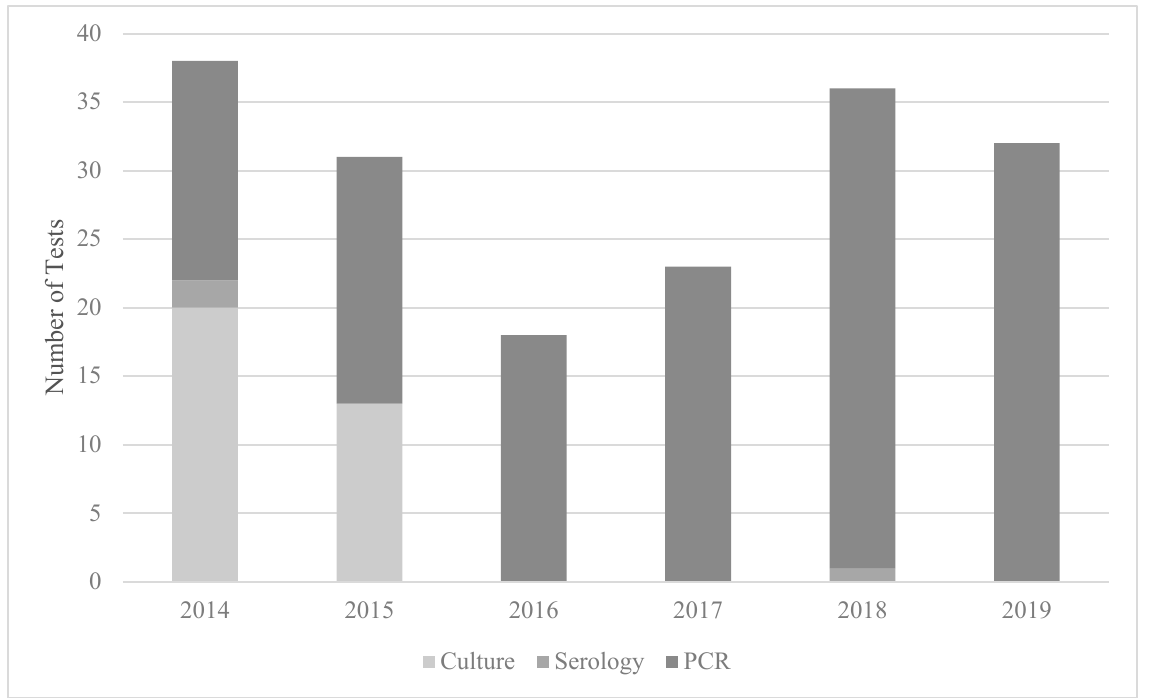
Figure 2. Testing modality for cCMV by year at a quaternary children’s hospital from 2014 to 2019. Abbreviations: PCR—quantitative polymerase chain reaction.